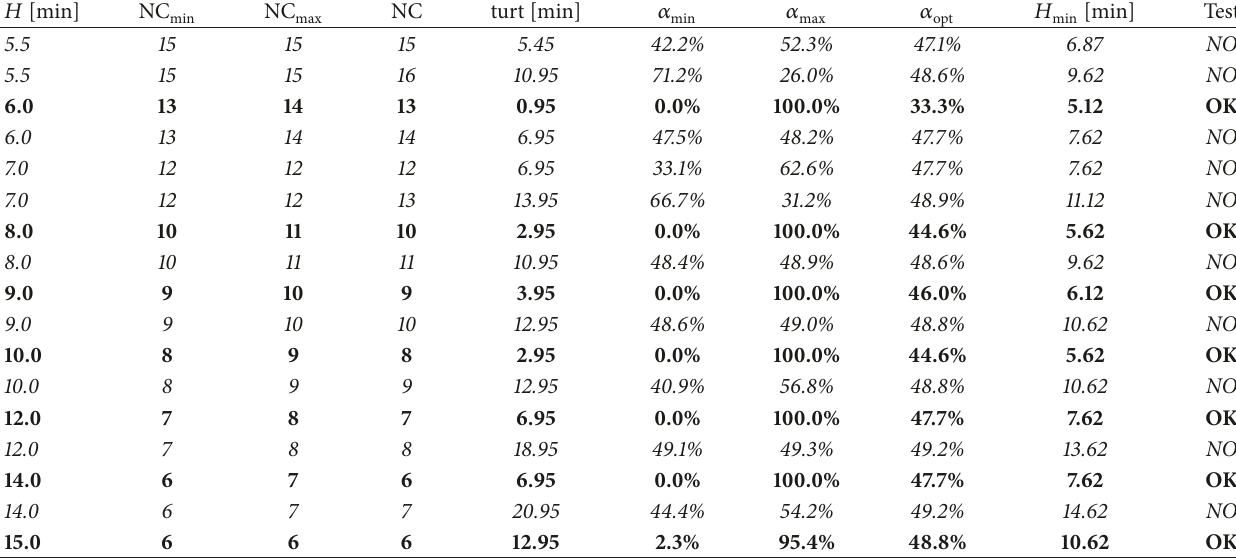
Table 5: Feasible configuration calculation in the case of the 99th